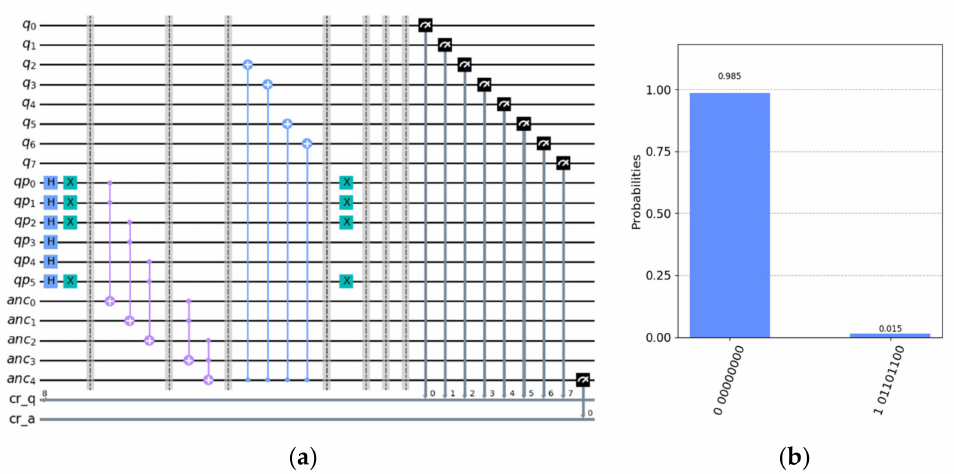
Figure 7. ( a ) The NEQR representation for the fourth pixel (gray level 108, LSB set to 0) and ( b ) the measurement